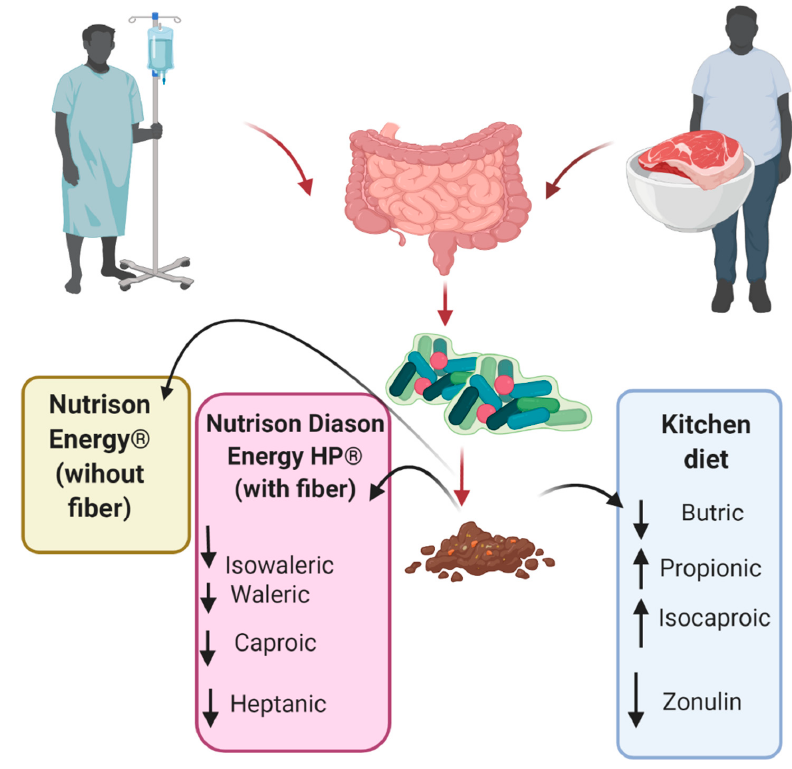
Figure 4. Overview of the results.